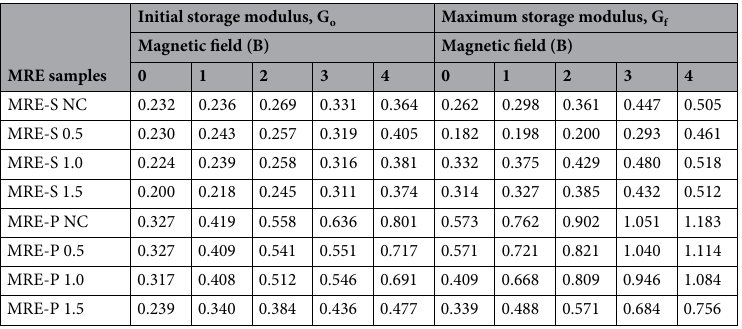
Table 3. Initial and maximum storage modulus of MRE samples.